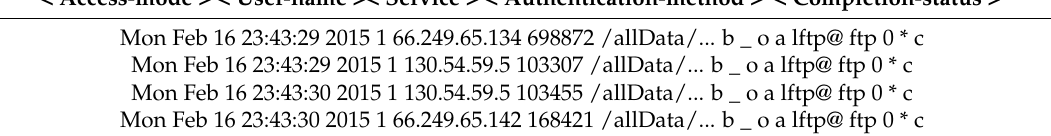
Table 2. Sample FTP log data in FTP Log